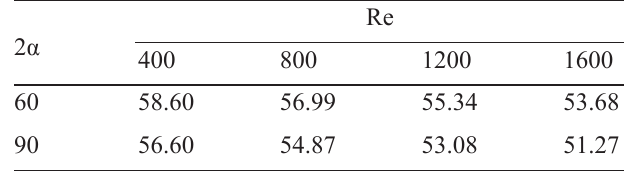
Table 2. Fully developed values of fRe for two apex